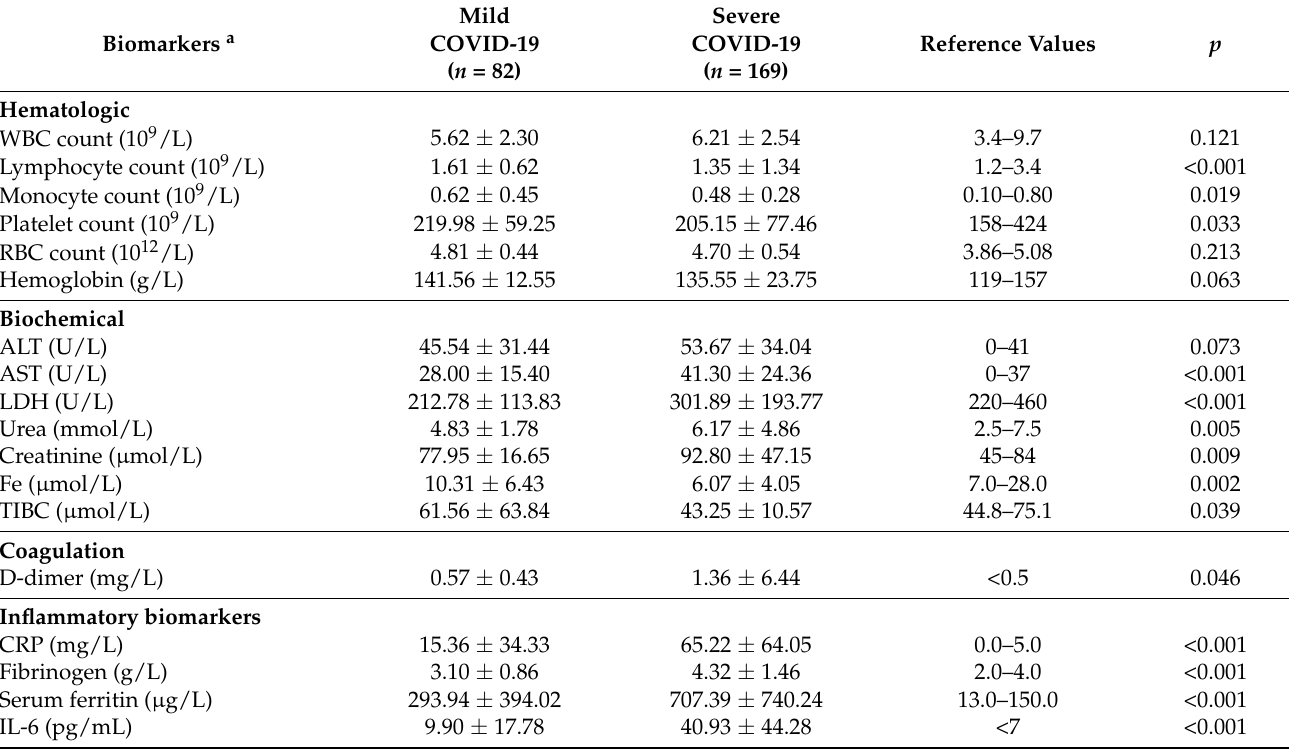
Table 2. Hematologic, biochemical, coagulation and inflammatory biomarkers in patients with mild and severe forms of COVID-19.